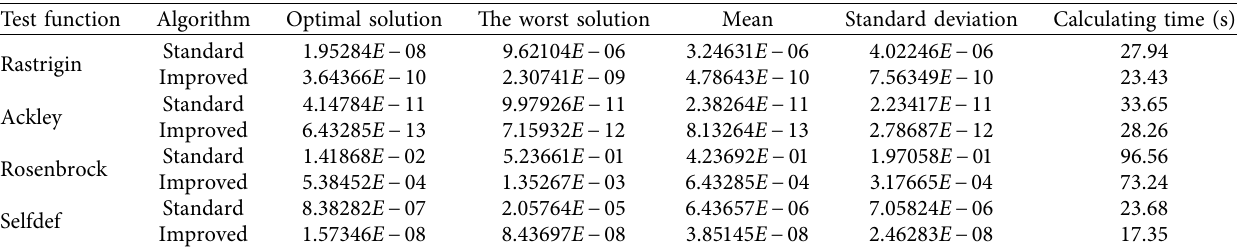
Table 4: Comparison of standard artificial bee colony algorithm and improved artificial bee colony algorithm. Test function